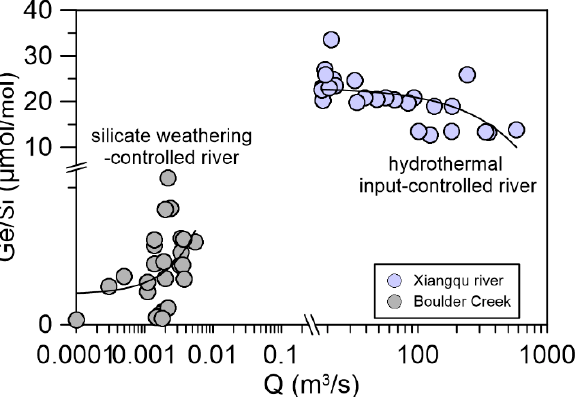
Figure 8. The plot of discharge versus Ge/Si ratio in silicate weathering- and hydrothermal input- controlled rivers. Data of Boulder Creek streams is from [46]. Adapted with permission from ref [46]. Copyright 2017 John Wiley and